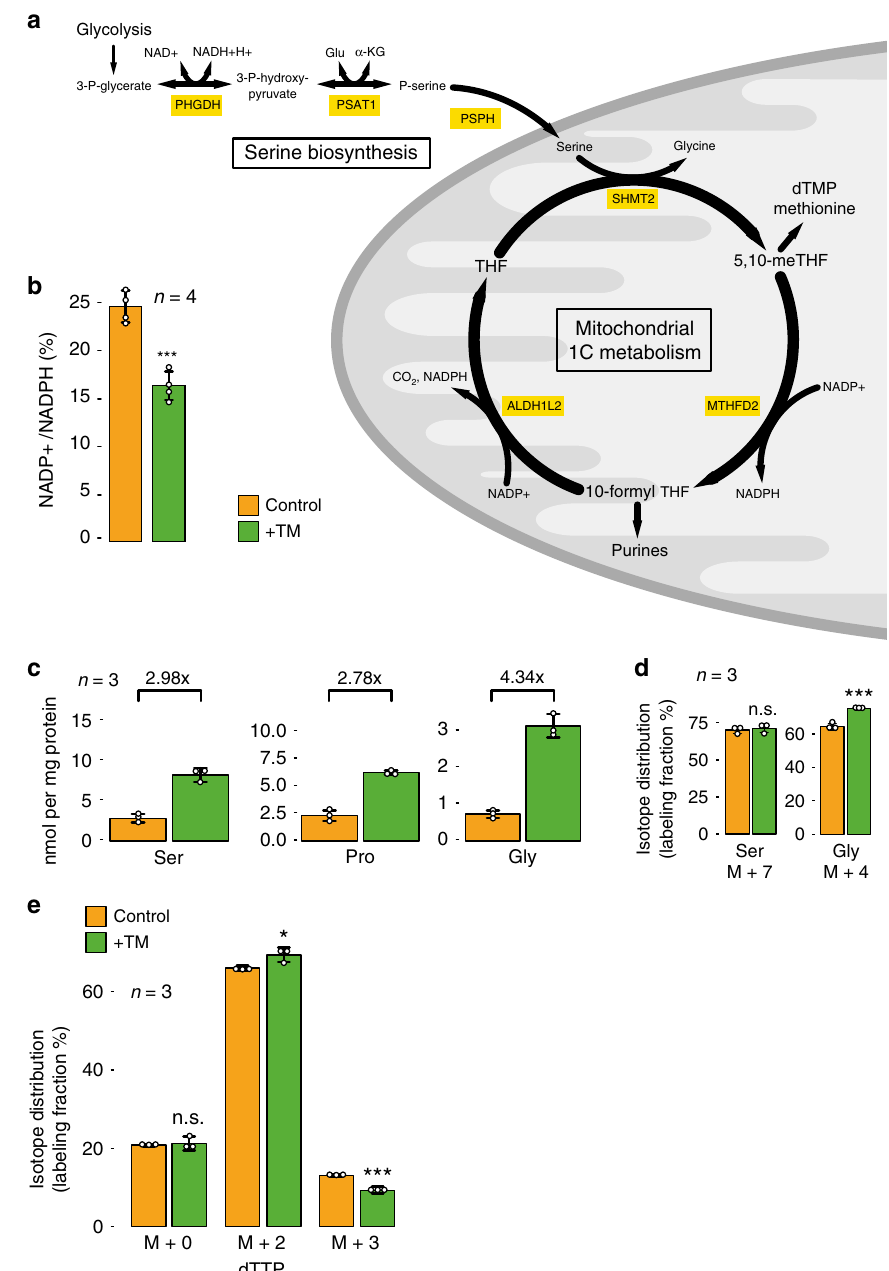
Fig. 5 The UPR induces rewiring of cellular metabolism. a Schematic depiction of the UPR-induced enzymatic pathway that diverts intermediary metabolites from glycolysis to fuel mitochondrial one-carbon metabolism via serine biosynthesis. PHGDH: phosphoglycerate dehydrogenase, PSAT1: phosphoserine aminotransferase 1, PSPH: phosphoserine phosphatase, SHMT2: serine hydroxymethyltransferase 2, MTHFD2: bifunctional methylenetetrahydrofolate dehydrogenase/cyclohydrolase, ALDH1L2: aldehyde dehydrogenase 1 family member L2, THF: tetrahydrofolate, 5,10-meTHF: 5,10-methylene THF. b Analysis of the redox status of the nicotinamide adenine dinucleotide phosphate pool in LN-308 cells after 24 h of control treatment with DMSO (yellow bar), or treatment with TM (green bar). P -value: 0.0003. c Analysis of the cellular concentration of the amino acids serine, proline, and glycine after induction of the UPR (green bars) relative to control treatment with DMSO (yellow bars). Fold-increase values after 24 h of treatment are displayed at the top of each panel. d Analysis of the isotope distribution of serine and glycine 24 h after application of a metabolically labeled serine tracer. Cells were either control treated with DMSO (yellow bars) or stimulated for 24 h with TM (green bars). P -values: Serine M + 7: 0.590, Glycine M + 4: 0.001. e Analysis of the contribution of mitochondrial folate metabolism to thymidylate synthesis in control-treated LN-308 cells (yellow bars), or after induction of the UPR with TM (green bars). The isotope distribution of dTTP was analyzed 24 h after administration of a metabolically labeled serine tracer. P -values: dTTP M + 0: 0.713, dTTP M + 2: 0.038, and dTTP M + 3: 0.002. All data are represented as mean ± SD of three ( c – e ) or four ( b ) biologically independent experiments. A Student ’ s t -test was used for the statistical testing with the following parameters: two-sided, true variance equality and con fi dence level at 0.95. No adjustment for multiple comparisons was made. n.s. not signi fi cant P > 0.05, * P < 0.05, *** P < 0.005. Source data are provided as a Source Data fi